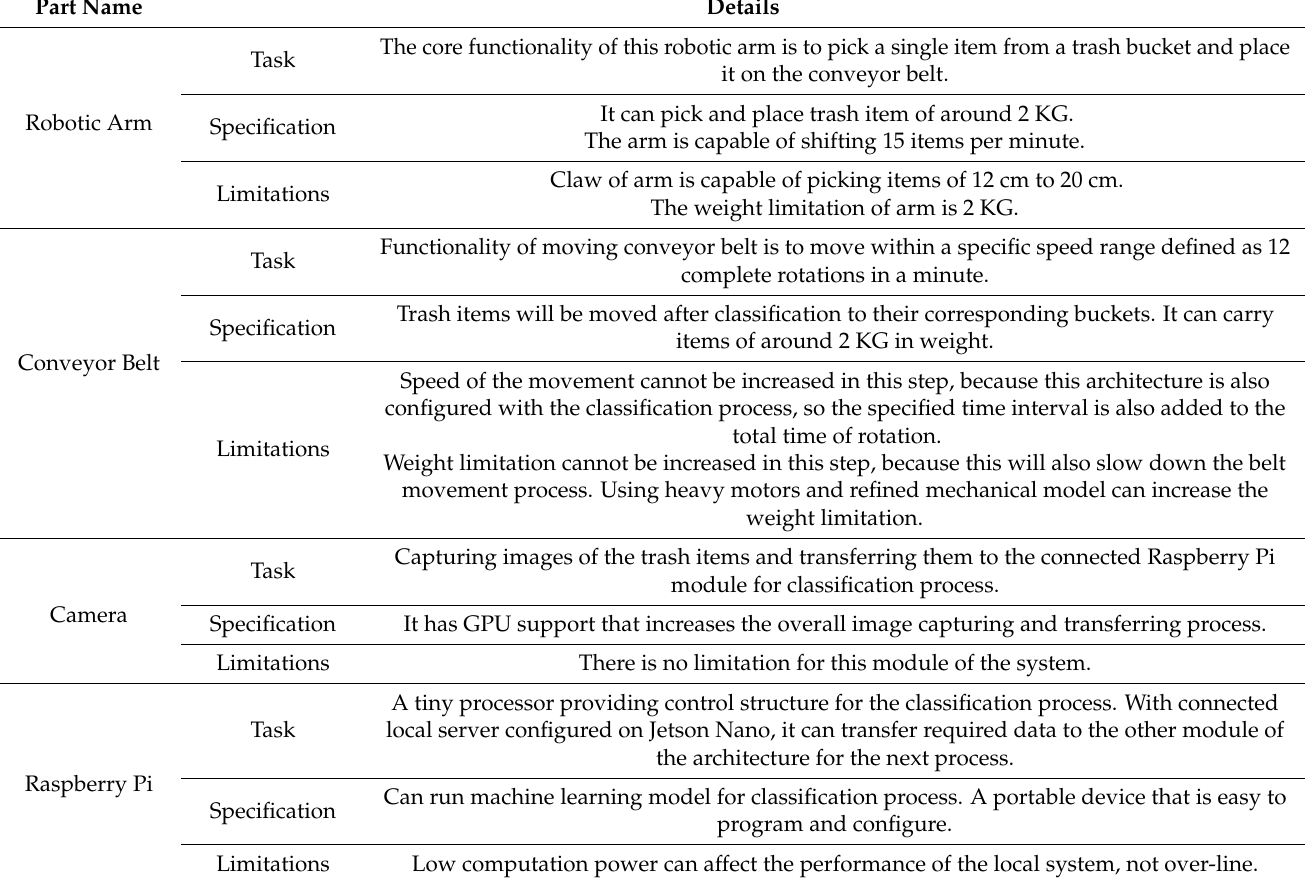
Table 1. Design specifications and limitations of implemented system